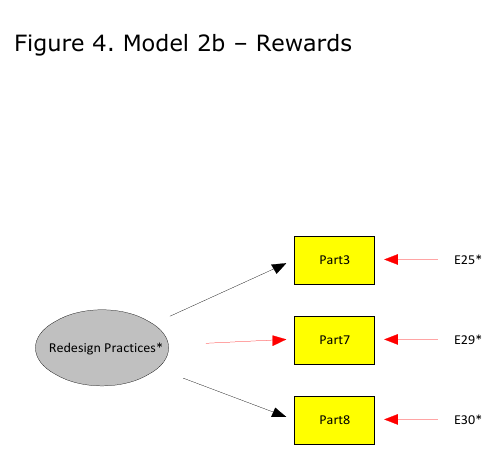
Figure 3. Model 2a – Rewards Figure 4. Model 2b – Rewards